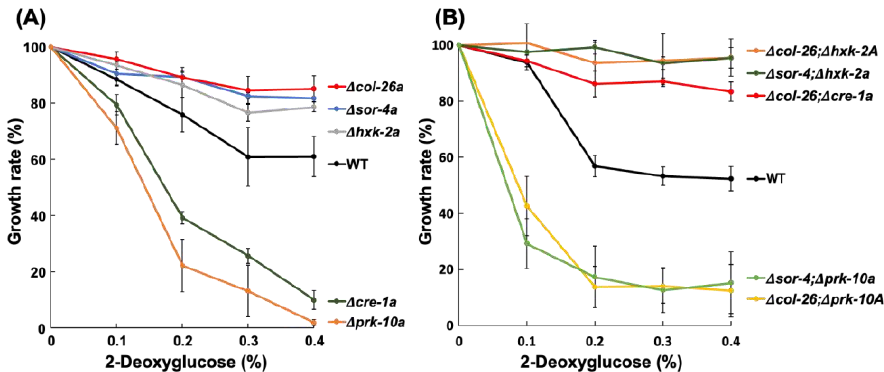
Figure 3. 2-Deoxyglucose resistance of the CCR mutants. ( A ) Single deletion mutants of hxk -2 , prk -10 , cre -1, col -26 and sor -4. ( B ) Their double mutants of col -26; hxk -2 , col -26; prk -10 , col -26; cre -1 , sor -4; hxk -2, and sor -4; prk -10. Mycelium disks precultured on Vogel’s minimal medium containing 1% fructose were inoculated on fructose medium containing 2-deoxyglucose (0.1%, 0.2%, 0.3%, and 0.4%) for 18 h at room temperature. The growth rate was calculated following formula: Growth rate (%) = {hyphal length of treatment (mm)/hyphal length of control (mm)} × 100. Three biological replicates were performed. Errors are expressed as the standard error.